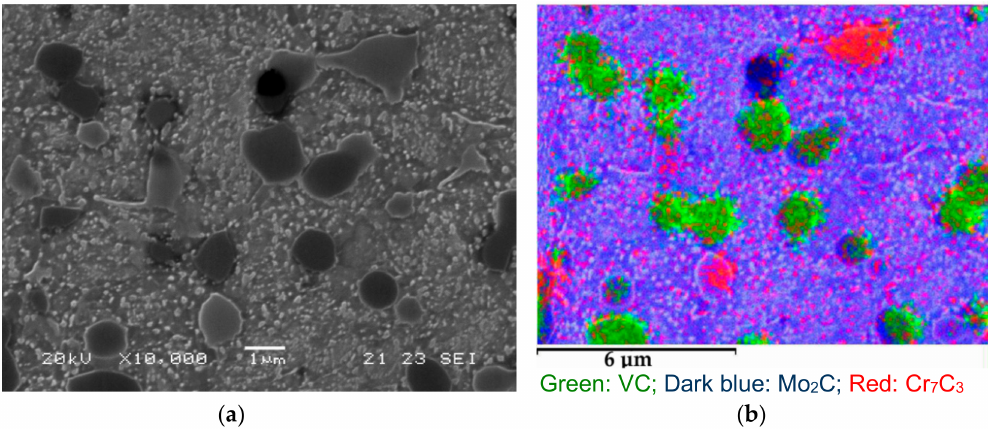
Figure 6. Distribution of carbides in the sample corresponding to Experiment 2. A single particle of Mo 2 C can be observed. Based on the reddish coloration in the matrix, it would appear that the majority of the precipitated secondary carbides are of the Cr 7 C 3 type. ( a ) Scanning electron microscopy (SEM) image. ( b ) Mapping of elements by means of energy dispersive X-ray (EDX)